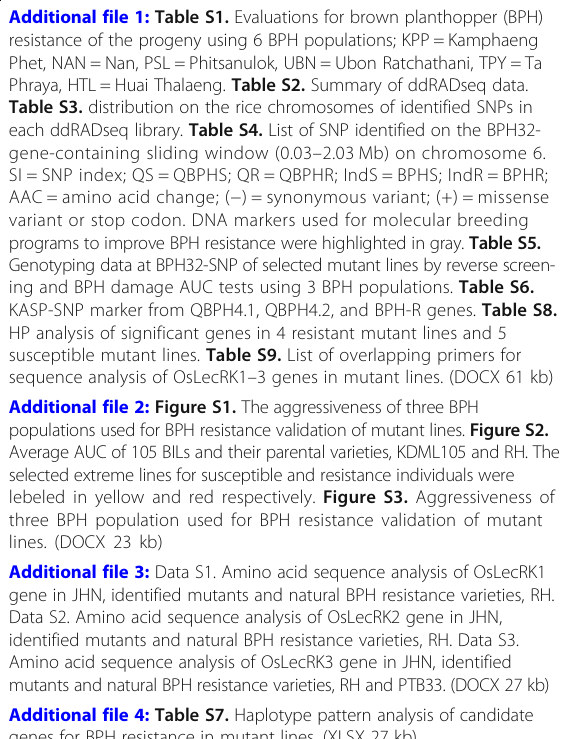
Table S3. distribution on the rice chromosomes of identified SNPs in each ddRADseq library. Table S4. List of SNP identified on the BPH32- gene-containing sliding window (0.03 – 2.03 Mb) on chromosome 6. SI = SNP index; QS = QBPHS; QR = QBPHR; IndS = BPHS; IndR = BPHR; AAC = amino acid change; ( − ) = synonymous variant; (+) = missense variant or stop codon. DNA markers used for molecular breeding programs to improve BPH resistance were highlighted in gray. Table S5. Genotyping data at BPH32-SNP of selected mutant lines by reverse screen- ing and BPH damage AUC tests using 3 BPH populations. Table S6. KASP-SNP marker from QBPH4.1, QBPH4.2, and BPH-R genes. Table S8. HP analysis of significant genes in 4 resistant mutant lines and 5 susceptible mutant lines. Table S9. List of overlapping primers for sequence analysis of OsLecRK1 – 3 genes in mutant lines. (DOCX 61 kb) Additional file 2: Figure S1. The aggressiveness of three BPH populations used for BPH resistance validation of mutant lines. Figure S2. Average AUC of 105 BILs and their parental varieties, KDML105 and RH. The selected extreme lines for susceptible and resistance individuals were lebeled in yellow and red respectively. Figure S3. Aggressiveness of three BPH population used for BPH resistance validation of mutant lines. (DOCX 23